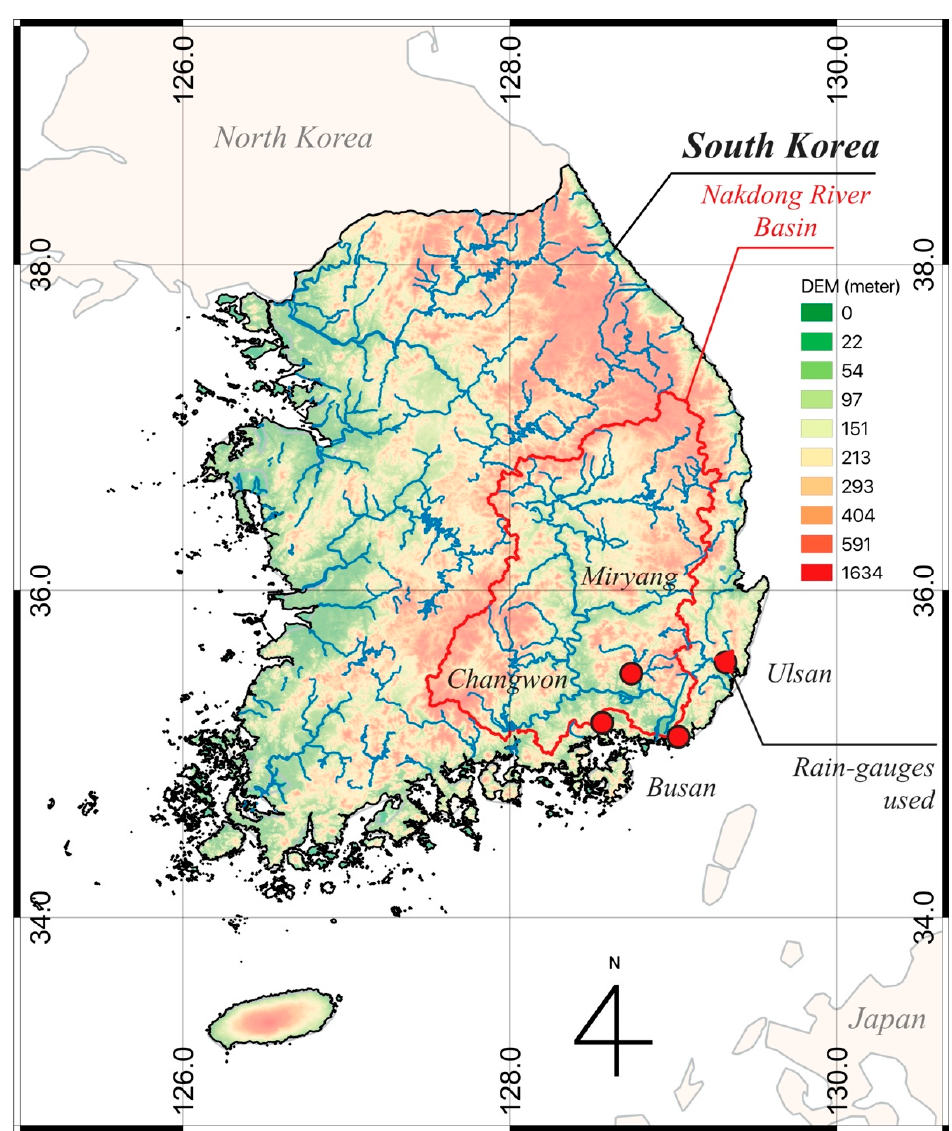
Figure 1. Nakdong estuary basin and weather stations.